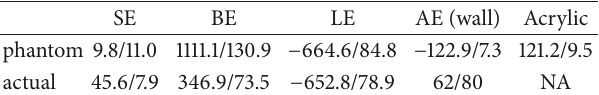
Table 1: Measured (average/standard deviation) attenuation values in HU of key phantom components vs. an actual patient with same ROI (100mm 2 ).